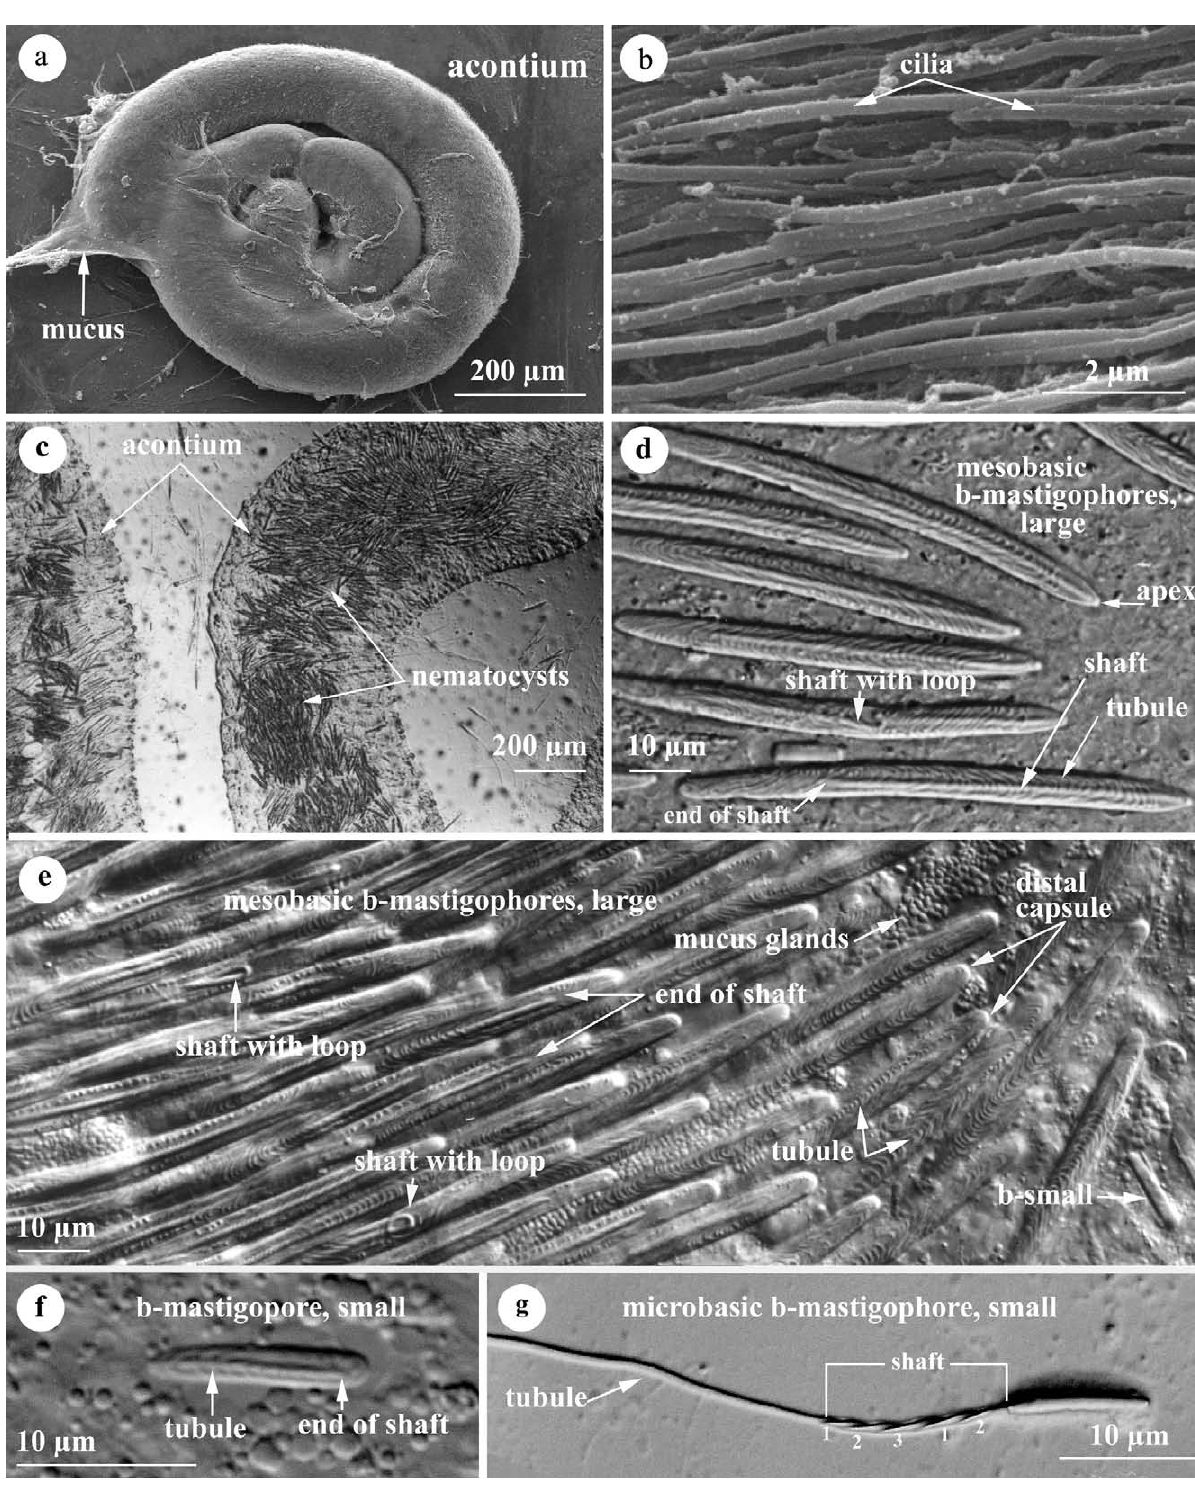
Fig . 1. – Acontia and acontia b-mastigophores. a) Part of an acontium partly covered with mucus (SEM). b) Surface of a) showing cilia (SEM). c) Parts of a compressed acontium showing nematocysts. d,e) Mesobasic b-mastigophores, large from acontium in c). d) Intact nematocysts to show shaft and tubule. e) Closely packed capsules in basal view. Note a small microbasic b-mastigophore at lower right. f,g) Microbasic b-mastigophores, small. g) Discharged. b-small, microbasic b-mastigophore, small; 1, 2, 3, three